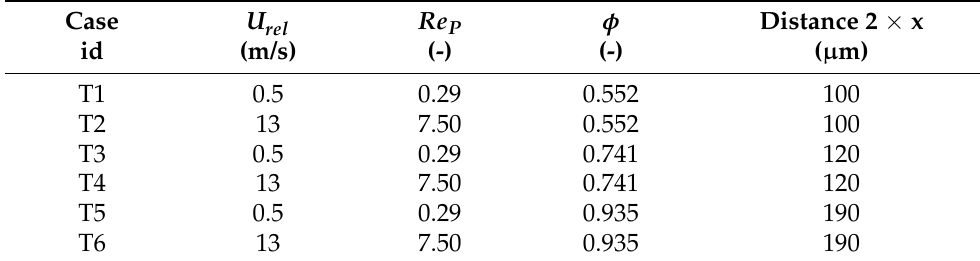
Table 1. Reference cases for the particle cluster